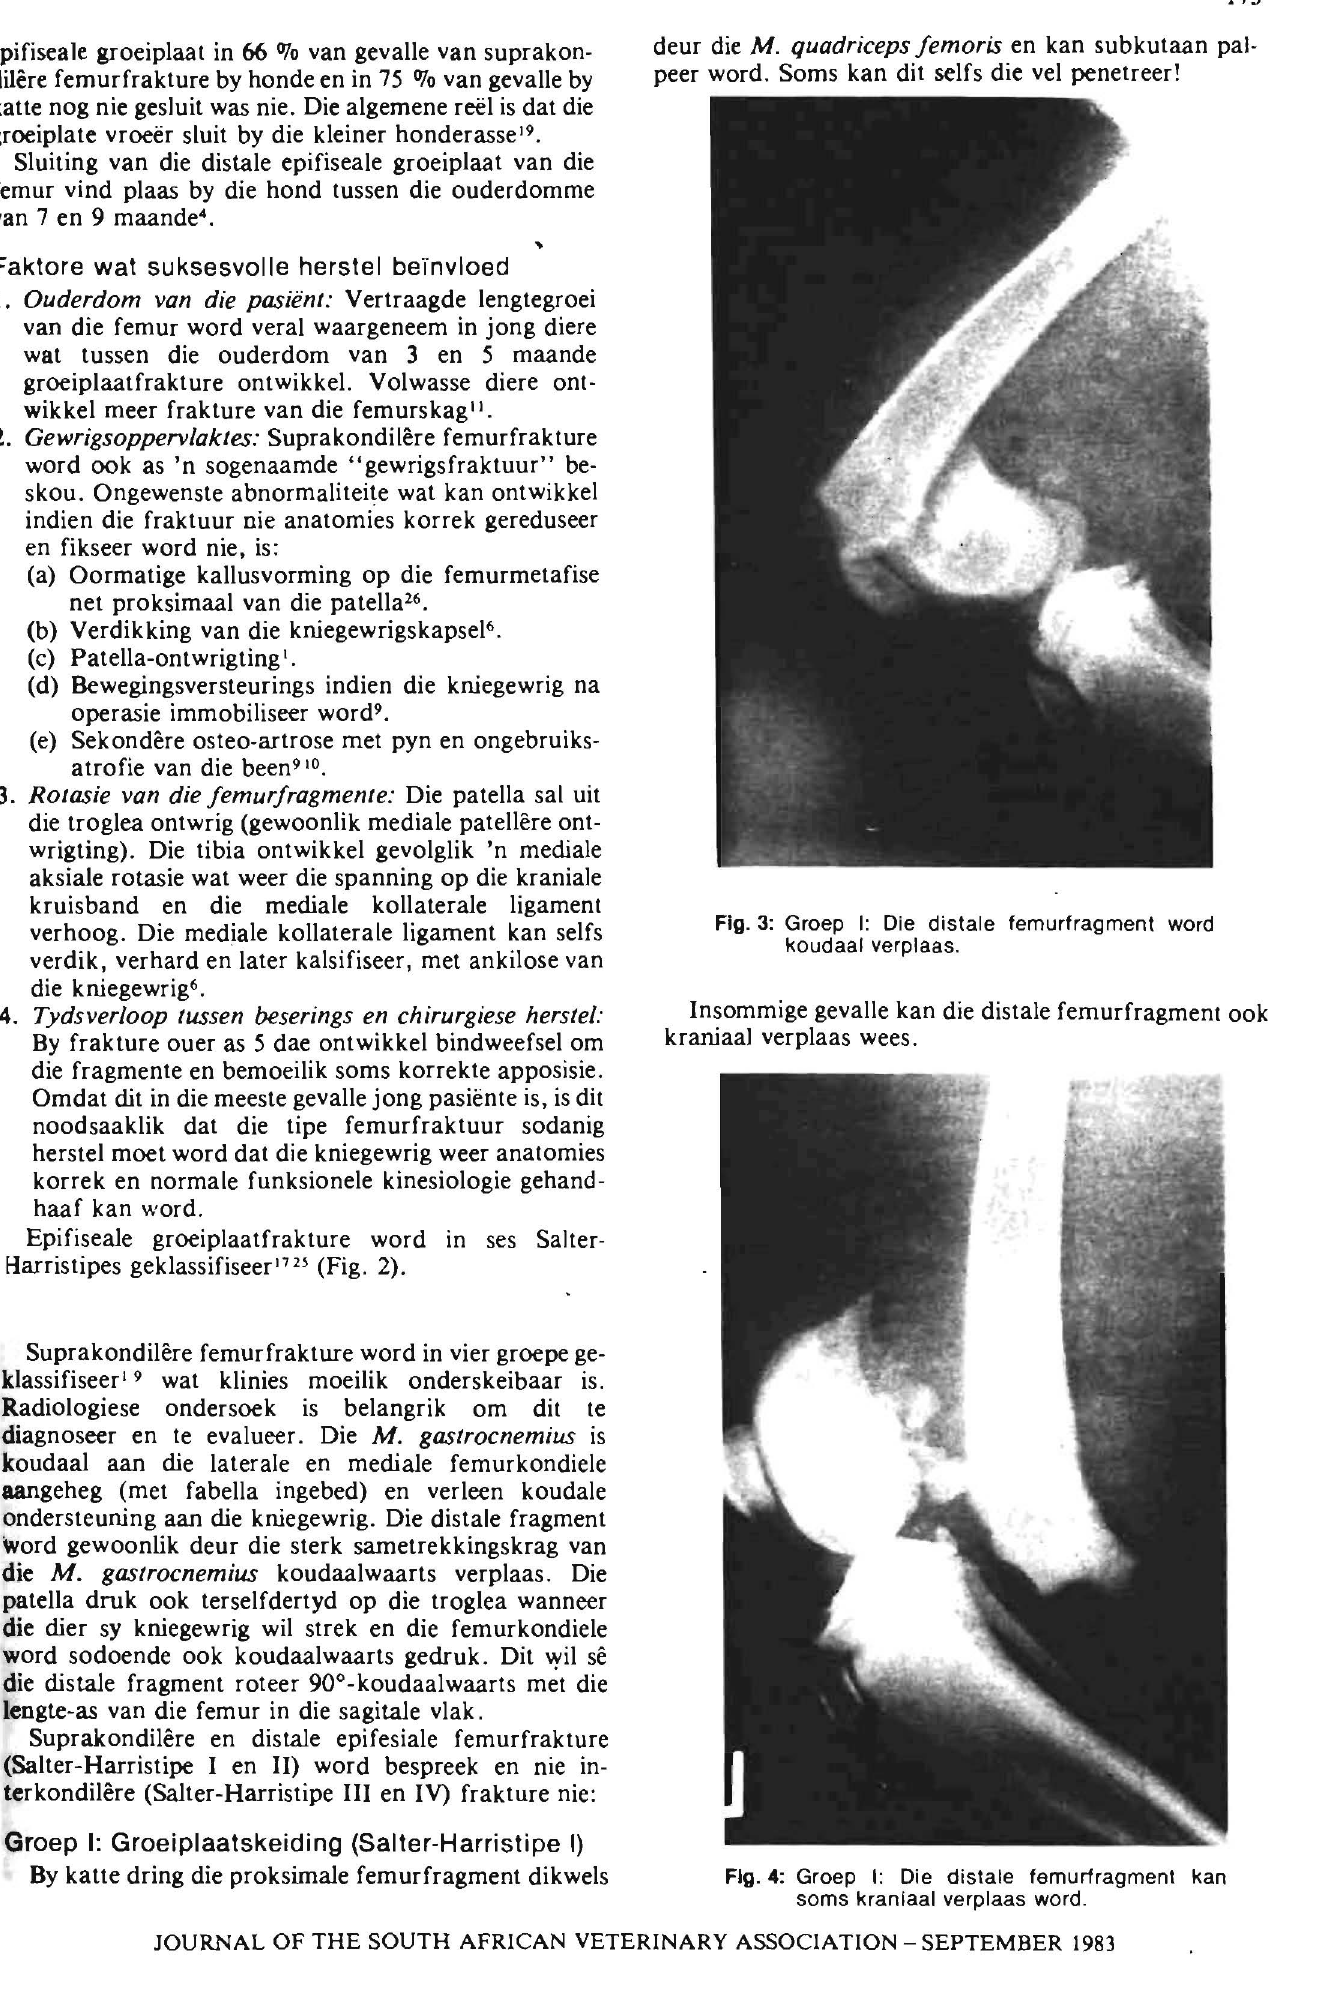
Fig. 3: Groep I: Die distale femurfragment word koudaal verplaas. Insommige gevalle kan die distale femurfragment ook kraniaal verplaas wees.